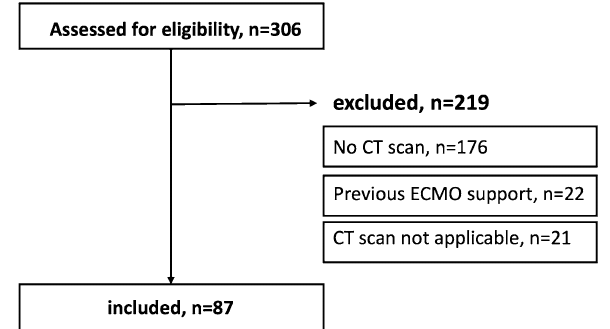
Figure 1. Study inclusion flowchart. Patients who received venovenous ECMO for severe acute respiratory failure between December 2014 and August 2018 at our center were screened for eligibility (n = 306). Patients were excluded if no CT scan within 4 days of ECMO initiation was available (n = 176), if they received previous ECMO support (n = 22), or if CT scans were not applicable (n = 21). CT Computed tomography, ECMO Extracorporeal Membrane